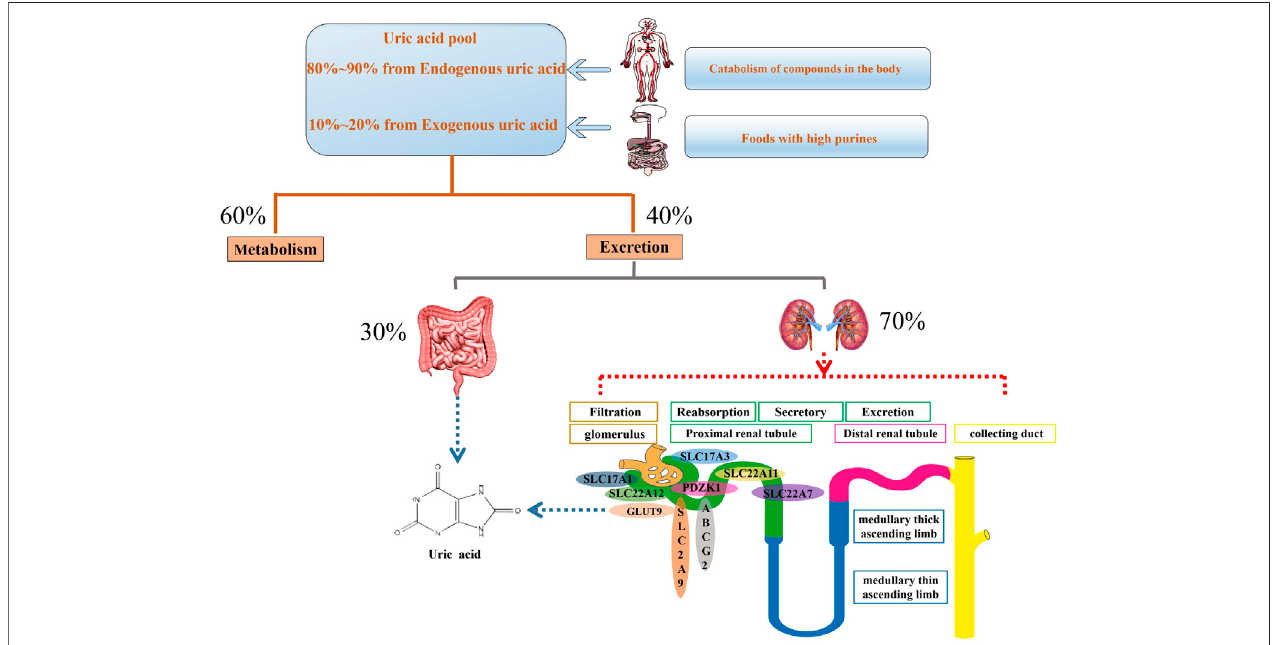
FIGURE 1 | Mainly physiological progression of uric acid in the body. Serum uric acid is original from uptake of foods containing a high level of purines as well as catabolismofproteinsandothercompoundsinthehumanbody.About60%uricacidinvolvesinmetabolismprocessandtherestofuricacidisexcretedthroughthegut and urethra. Urethral excretion is the main way. A series of urate transporters including SLC and ABC transporters expressed in urethra, especially the proximal convoluted tubules, maintain urate homeostasis.